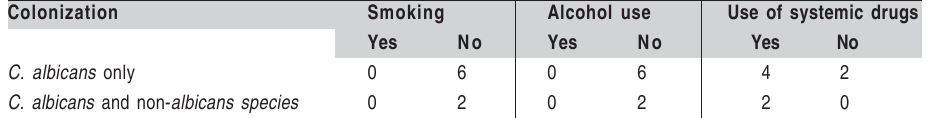
Table 2 - Distribution of primary colonization of Candida species in patients without denture stomatitis (Control